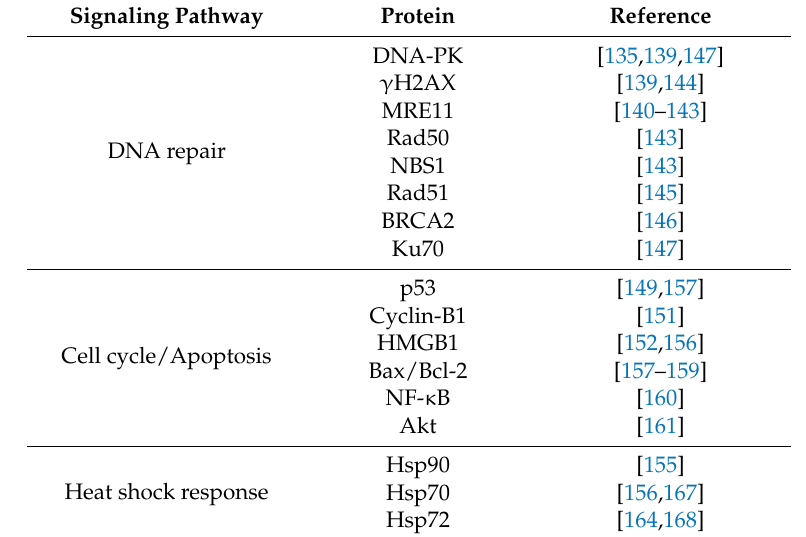
Table 1. Signaling pathway and proteins induced by combination of hyperthermia